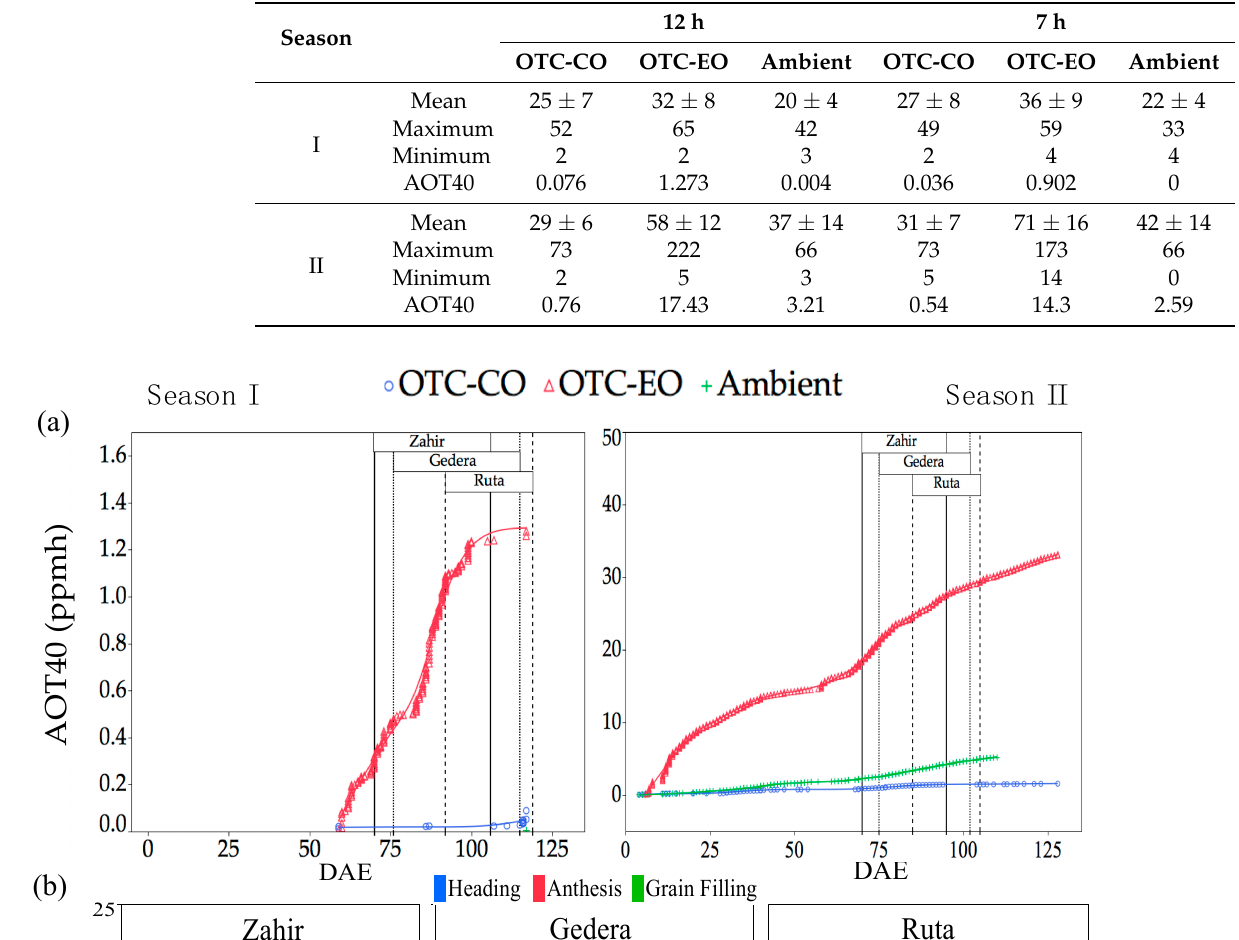
Table 3. O 3 concentrations and AOT40. Daytime 12 h and 7 h O 3 (ppbv) mean (M12, M7), maximum and minimum, and AOT40 (ppmh) from flag leaf emergence to plant maturity in control OTC (OTC-CO), O 3 -enriched OTC (OTC-EO), and ambient air, individually for season I and season II.